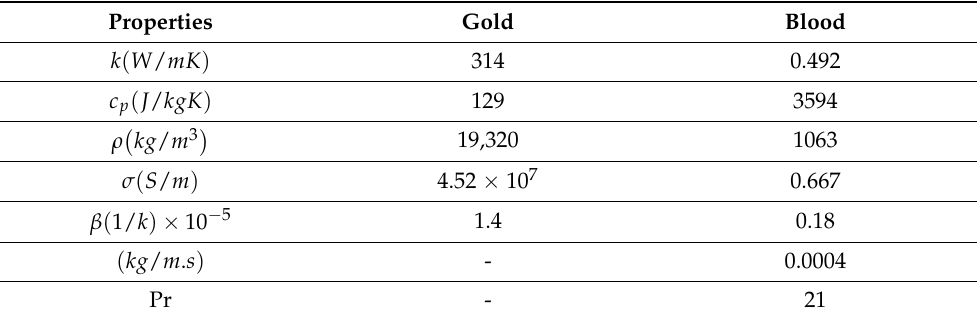
Table 1. Thermophysical properties of gold nanoparticles and base fluid (blood)